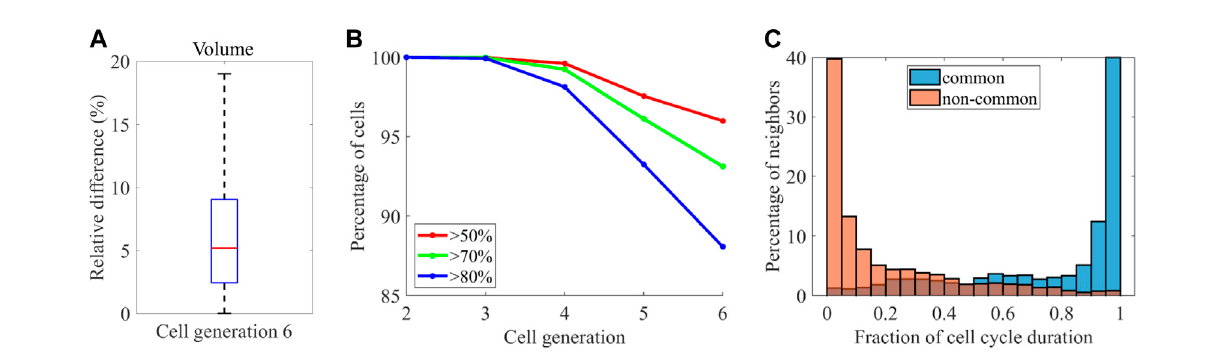
FIGURE 7 Comparisonwith P.mammillata (A) Variabilityofthemedianvolumeofthecellcycleacrosstheembryosatthegenerationsix (B) Percentageofcells at each cell generation showing conservation in neighborhood larger than the indicated thresholds (C) Histogram showing the distribution of contact duration of common neighbors (blue) and non-common neighbors